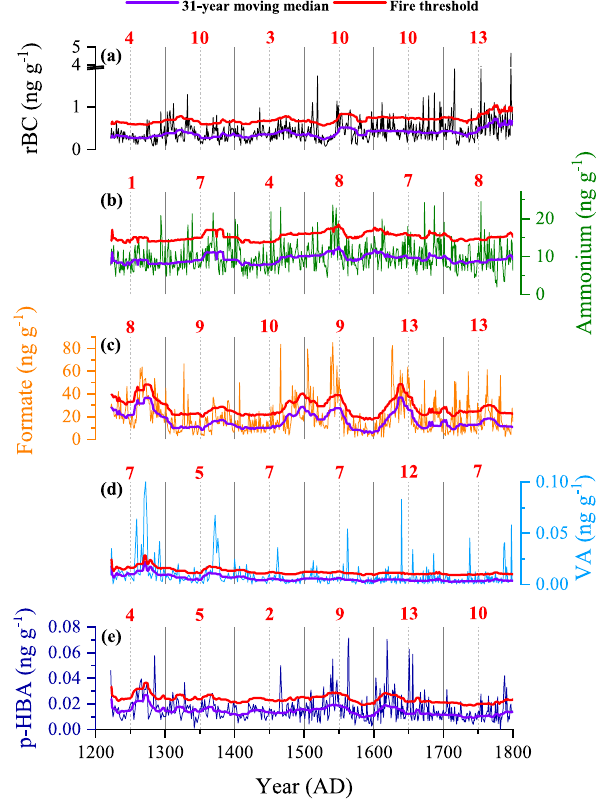
Figure 7. Paleofire trends in the LF-09 ice core using (a) rBC, (b) ammonium, (c) formate, (d) vanillic acid (VA), and (e) p - hydroxybenzoic acid ( p -HBA) along with 31-year moving medians and the associated fire threshold. Thin lines are annual averages. Red numbers above the respective plots represent the number of years above the fire threshold per century, corrected for neighboring outliers. Ammonium and formate data are from Wendl et al. (2015) while VA and p -HBA data are from Grieman et al.